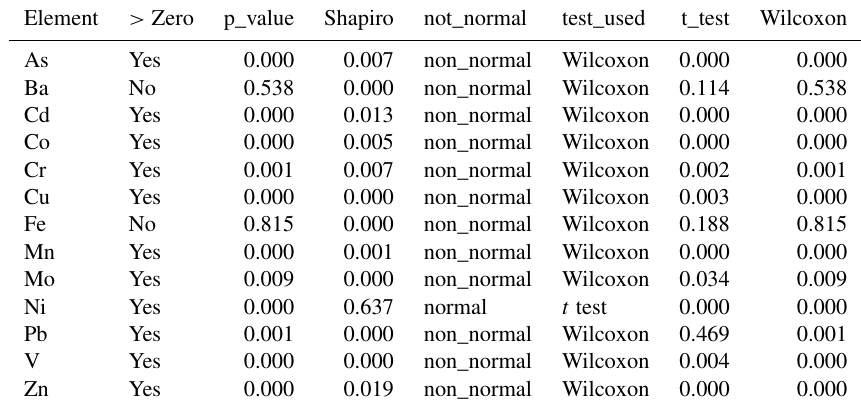
Table 4. Are dust-corrected plankton concentrations statistically different from zero for 2012 data?